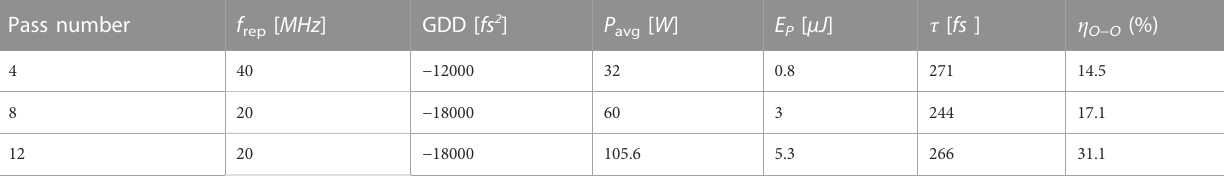
TABLE 1 Parameters of the realized oscillators with different thin-disk passes. f rep , repetition rate; GDD, intra-cavity dispersion; P avg , average power; E P , pulse energy; τ , pulse duration; η O − O , optical-to-optical ef fi ciency. Pass